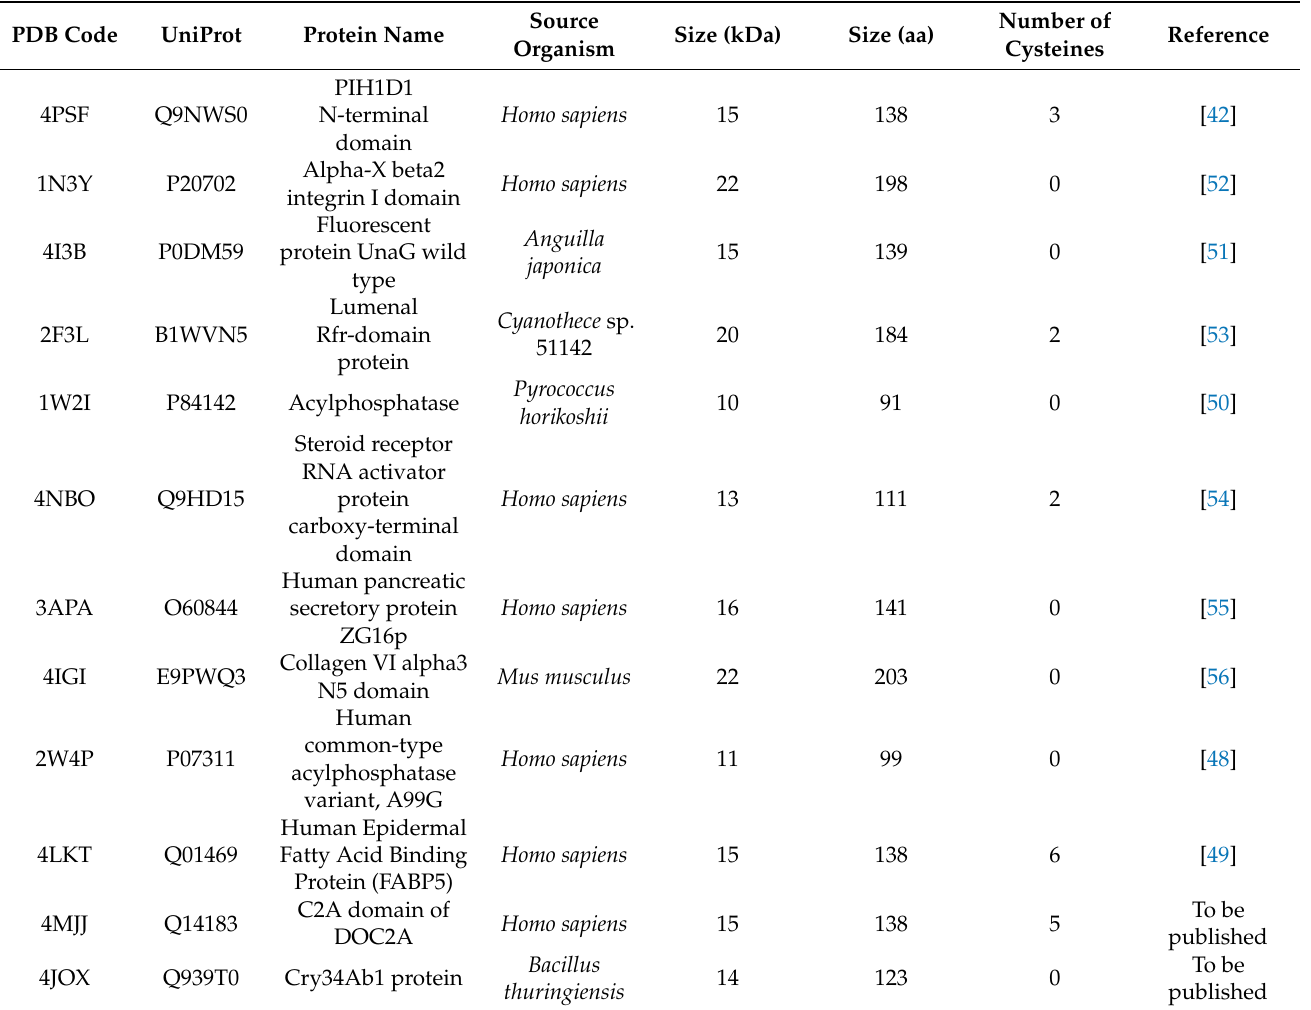
Table 1. List of protein scaffold candidates that were selected for closer in silico structural analysis and literature review. The first five candidates were chosen for further experimental